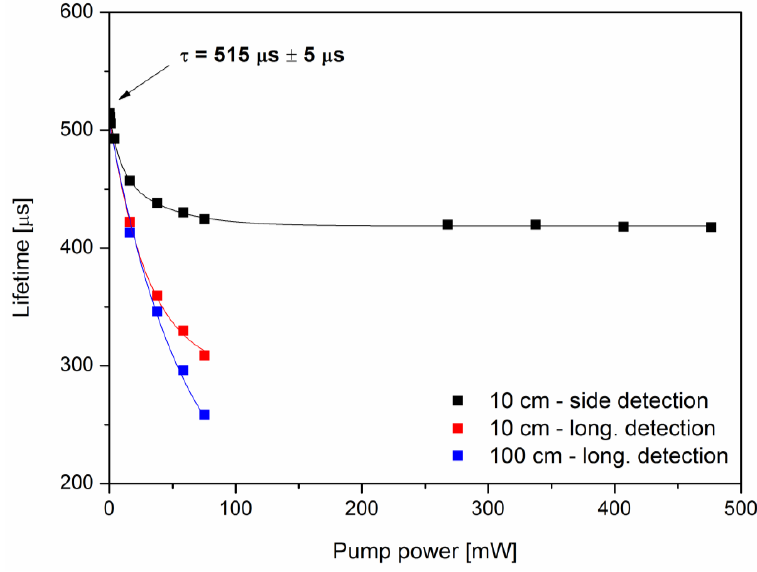
Figure 7. Fluorescence lifetime evaluated by extrapolation from different fiber lengths and pump powers for SD optical fiber in longitudinal- and side-detection arrangements.